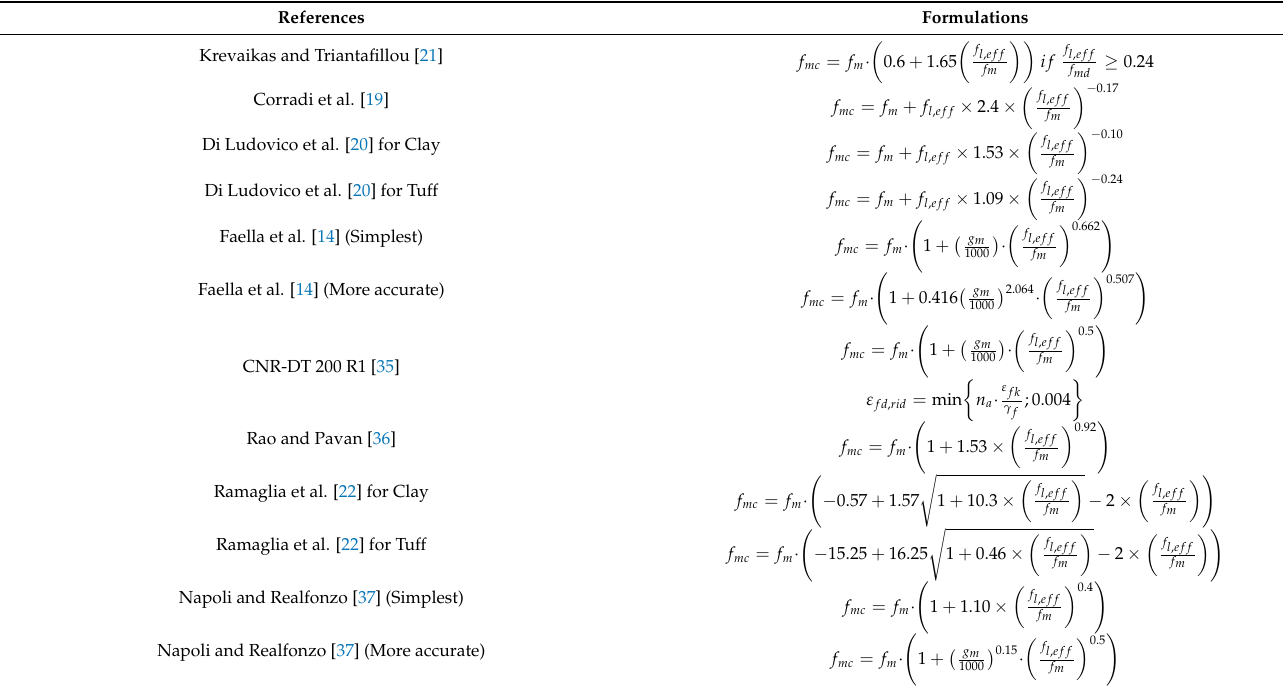
Table 1. Analytical models of gaining strength of FRP confined concrete